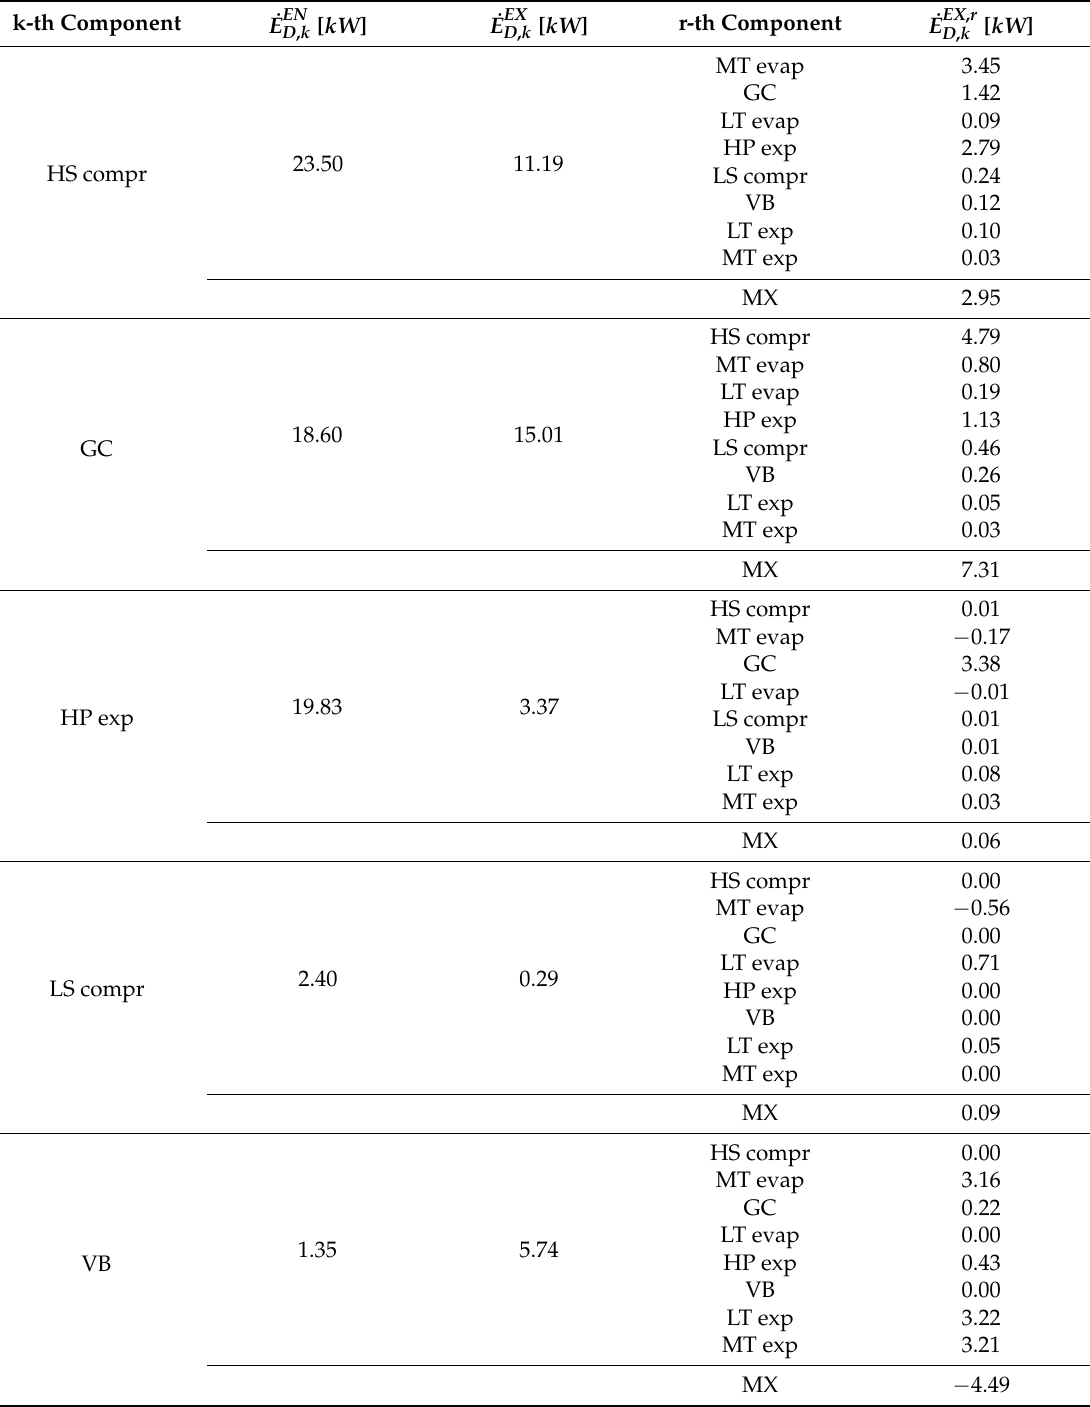
Table 9. Mexogenous exergy destruction rates of the components belonging to CB at the outdoor temperature of 40 ◦